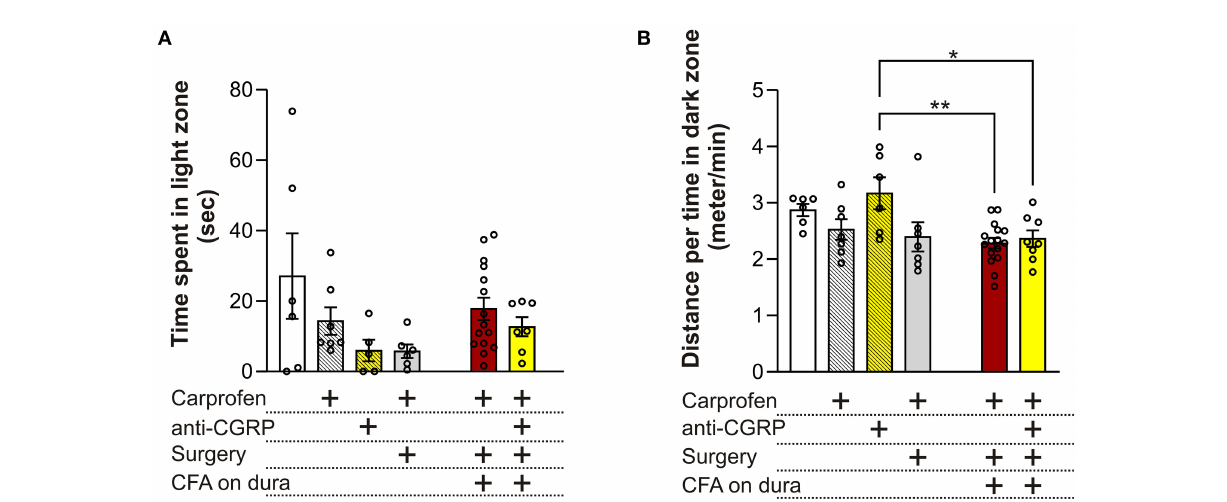
FIGURE3 Behavioral results from the LDB test (A) No significant differences on time spent in the light zone were observed between the groups. (B) No significant differences on the distance traveled during time spent per minute in the dark zone were observed between fresh + carprofen rats, fresh + anti-CGRP rats nor sham rats when compared with fresh rats. No significant difference was observed between sham rats and fresh + carprofen rats. No significant differences on the distance traveled during time spent in dark zone were observed between fresh rats, fresh + carprofen nor sham rats when compared with CFA rats. No significant differences were observed on the distance traveled during time spent in the dark zone between fresh rats nor fresh + carprofen rats when compared with CFA + anti-CGRP rats. CFA + anti-CGRP rats traveled significantly more during their time in the dark zone than fresh + anti-CGRP rats. No significant difference was observed between sham rats and CFA + anti-CGRP rats. Data are shown as mean ± SEM, and p values (* p < 0.05, ** p < 0.01) from the One-Way ANOVA and Tukey post-tests are depicted in the